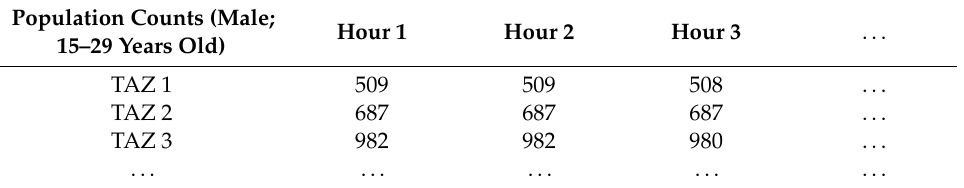
Table 3. Sample output of population